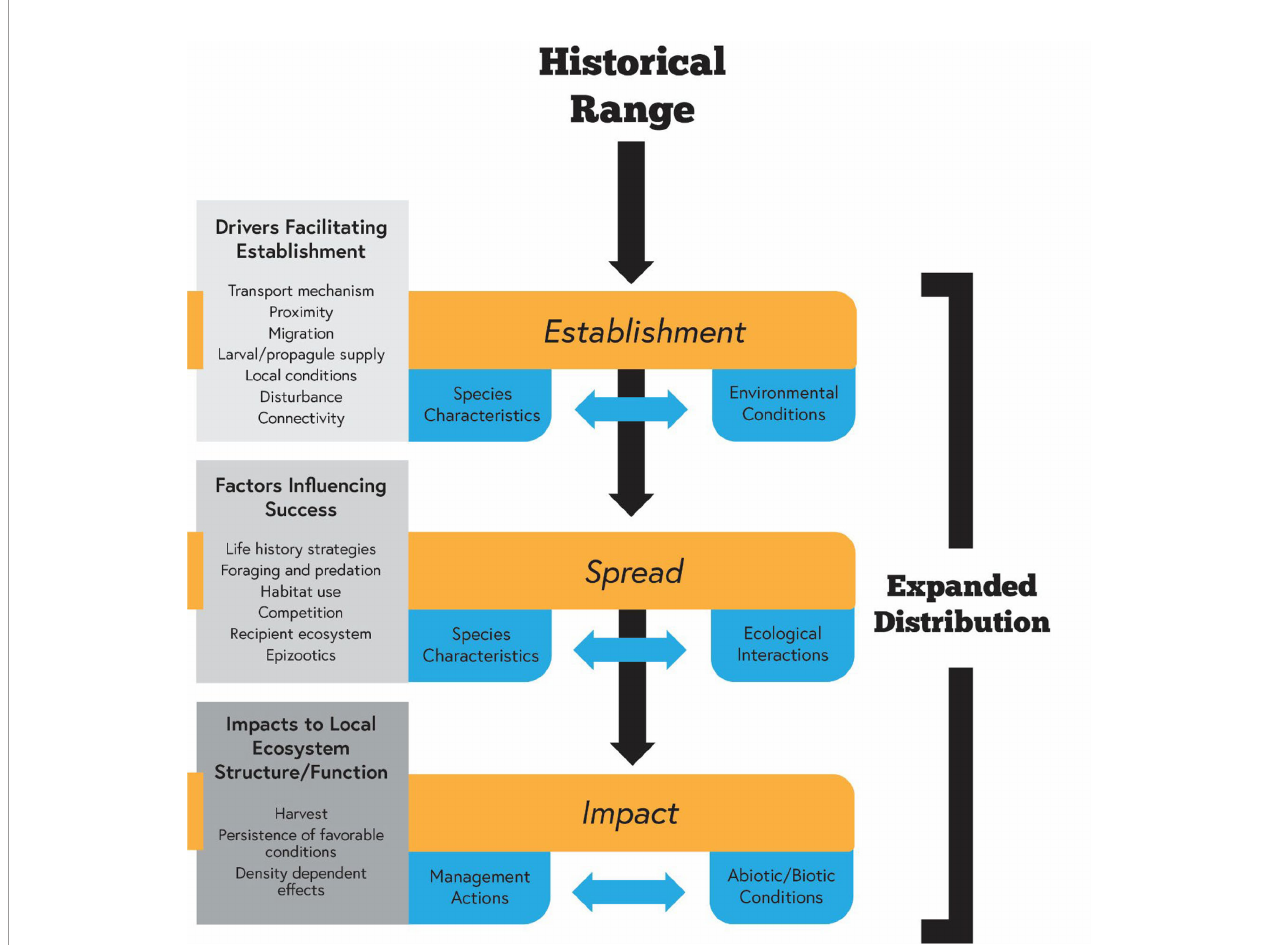
FIGURE 1 | Conceptual diagram highlighting a subset of the important factors in fl uencing the poleward geographic expansion and effects of mesopredators in seagrass ecosystems. Speci fi c attention is given to drivers facilitating establishment, factors in fl uencing success once established, and impacts within the expanded geographic